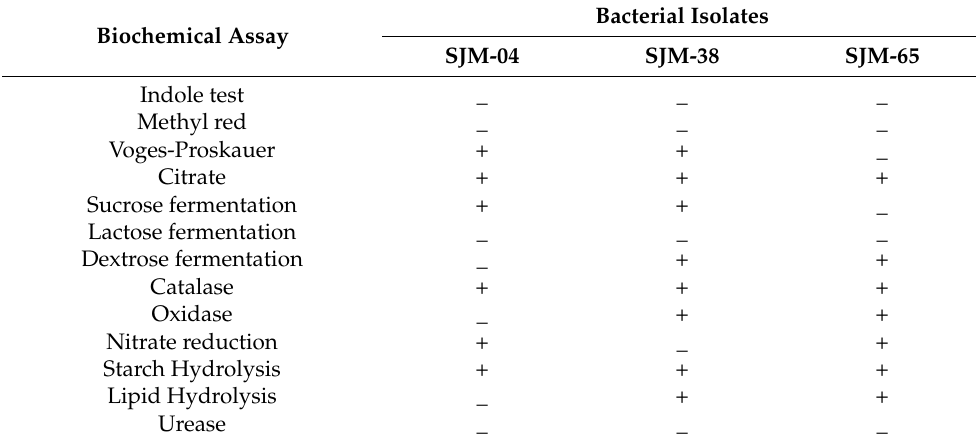
Table 2. Biochemical characterization of Gram positive coccoid oral bacterial isolates.